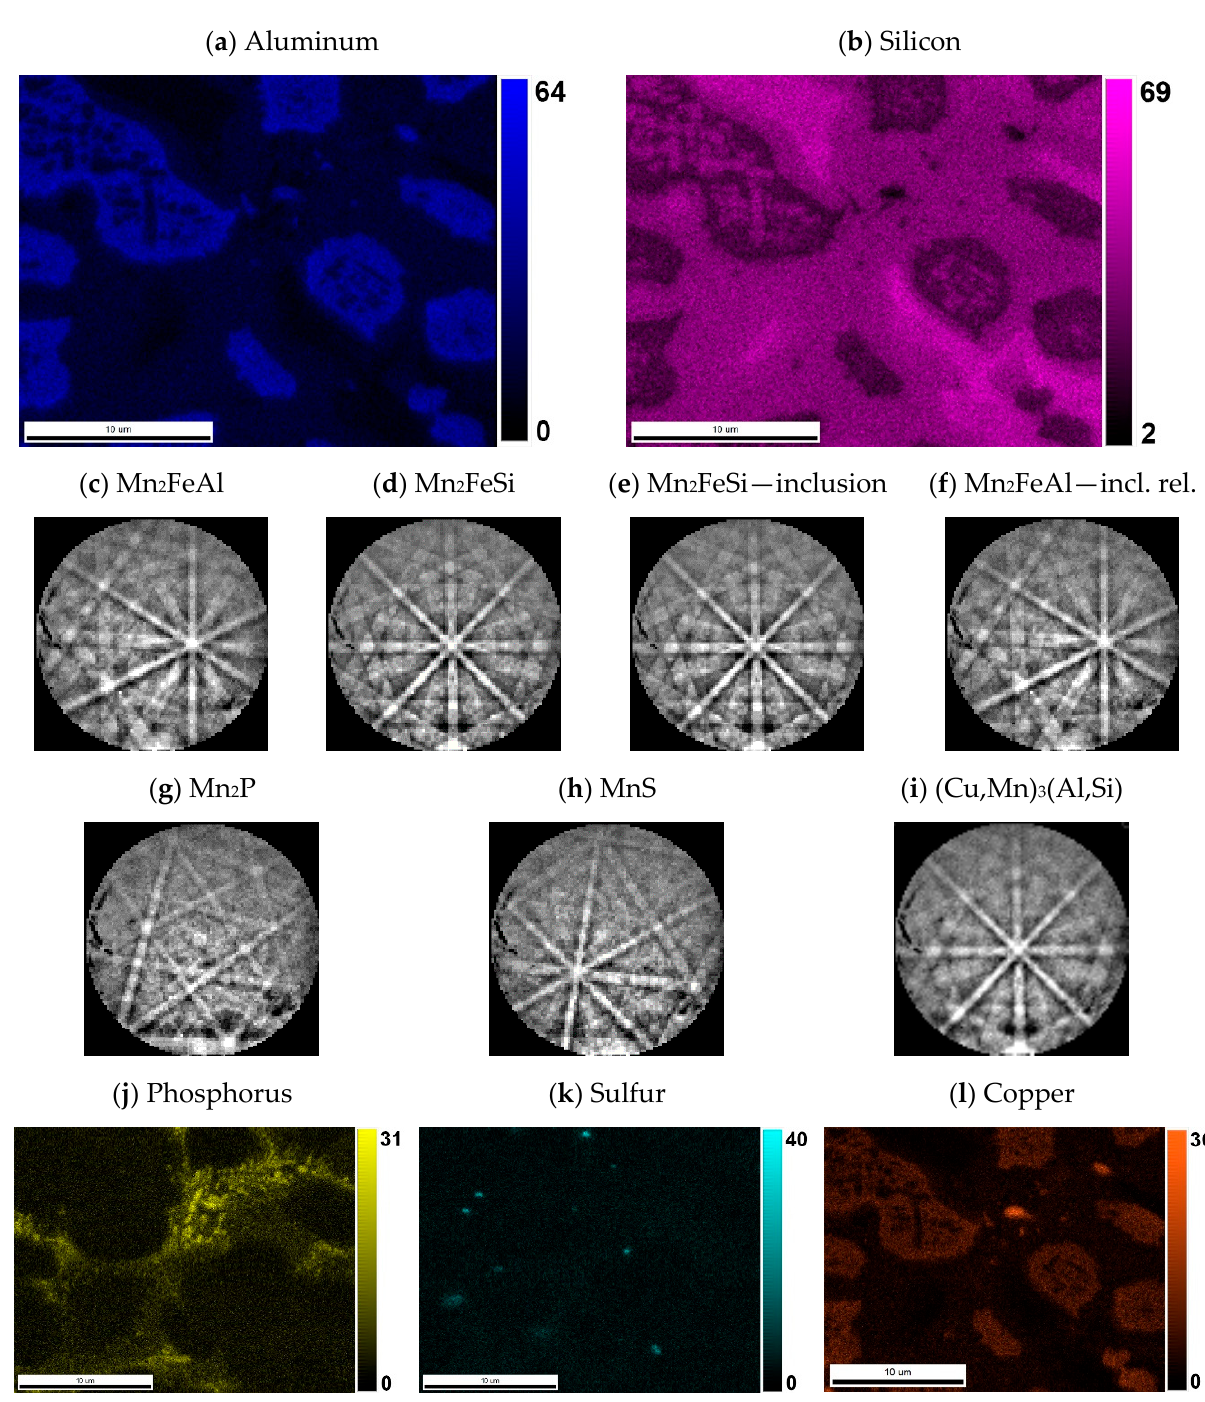
Figure 6. The content of ( a ) aluminum and ( b ) silicon in the sample with 10% excess of aluminum. The distribution of both elements was used for the segmentation of similar Heusler phases Mn 2 FeAl and Mn 2 FeSi. Both phases have different Kikuchi patterns: ( c ) Mn 2 FeAl has more blur bands than ( d ) Mn 2 FeSi, not only in one phase grain, but even in ( e ) inclusions of Mn 2 FeSi and close ( f ) Mn 2 FeAl matrix. Minor phases are represented by Mn 2 P ( g ) related to increased phosphorus—see ( j ), ( h ) MnS related to content of sulfur—see ( k ); and even high copper—see ( l ); content gives rise to ( i ) (Cu,Mn) 3 (Al,Si) with a different character of Kikuchi pattern.